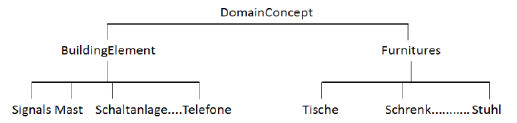
Figure 6. Detailed Iterative Semantic Classification